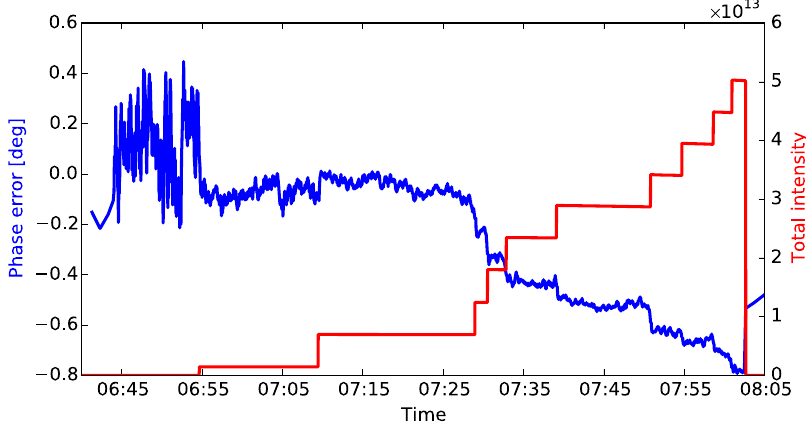
FIG. 2. Example of average phase shift (blue) and total beam intensity (red) of Beam 1 at the LHC flat bottom (450 GeV) during the injection of trains of 48 bunches spaced by 50 ns from the SPS. Note the phase change after each bunch train injection. Fill 1502